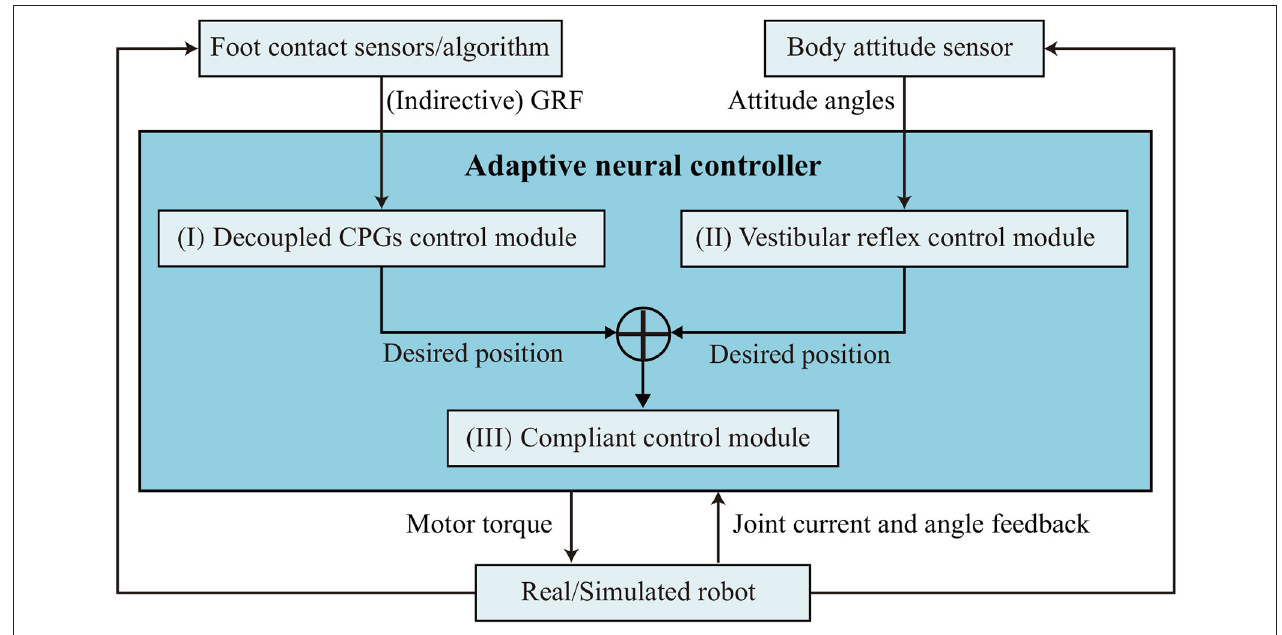
FIGURE 5 | Framework of adaptive neural